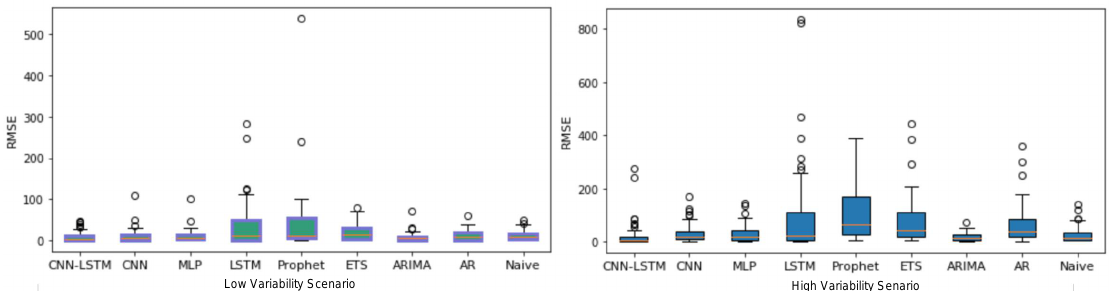
Figure 19. RMSE error distribution across the cells for both low ( left ) and high ( right ) variability scenario. Graphics shows that both the ARIMA method and CNN-LSTM deep learning method can give good results in high and low variability scenario.